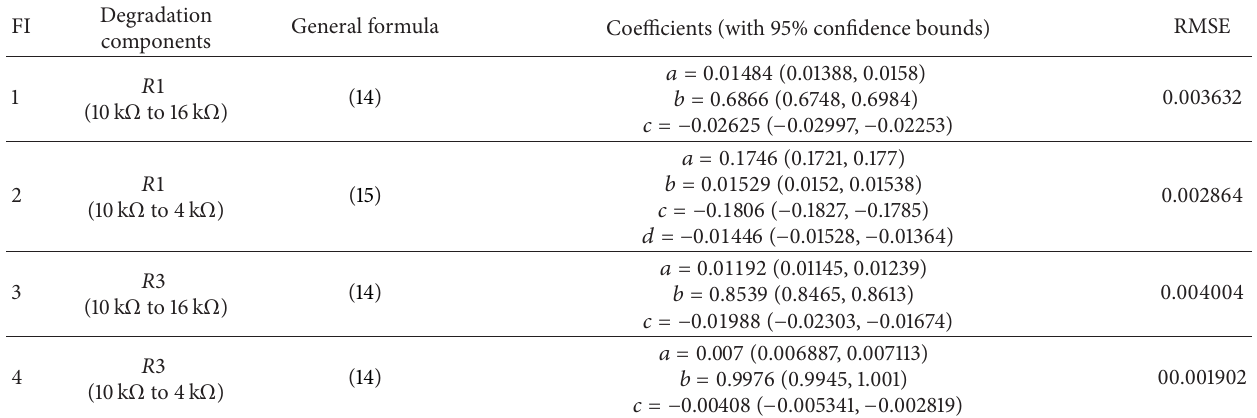
Figure 8: (a) The FI degradation model about the situation that 𝑅1 deviates from 10k Ω to 16k Ω . (b) The FI degradation model about the situation that 𝑅1 deviates from 10 k Ω to 4 k Ω . Table 1: Fitting formulas and effect of equations related to FI data